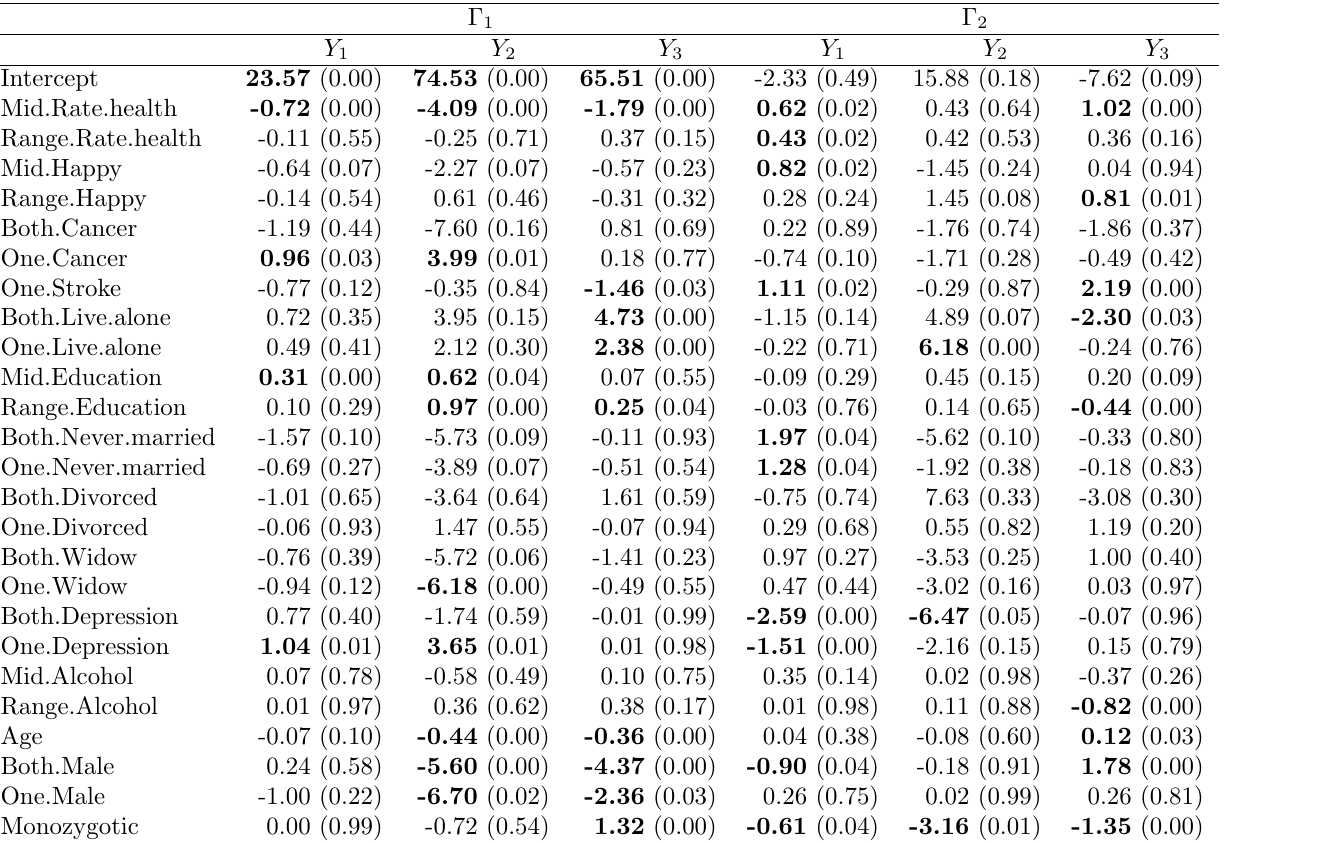
Estimated regression coefficients of the matrix-variate regression model. In brackets the p -values associated to the null hypothesis of each single coefficient are reported. In the table Y 1 refers to the ‘mental status’, Y 2 is the ‘episodic memory’ and Y 3 refers to the ‘Lawton’s IADL’. Γ